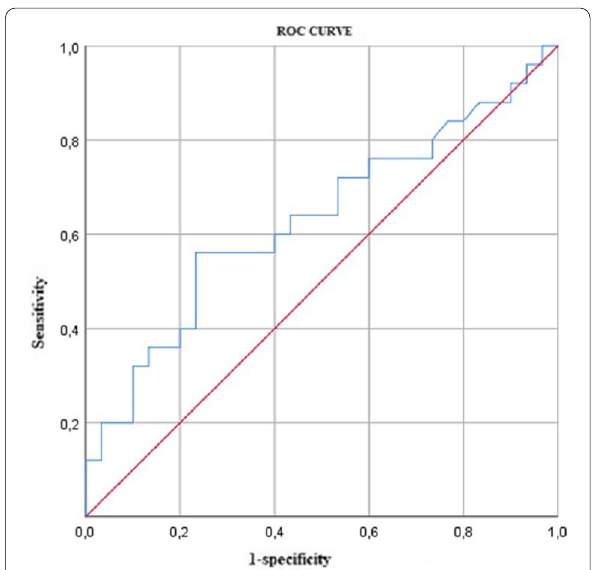
Fig. 1 ROC curve analysis between prostate cancer and